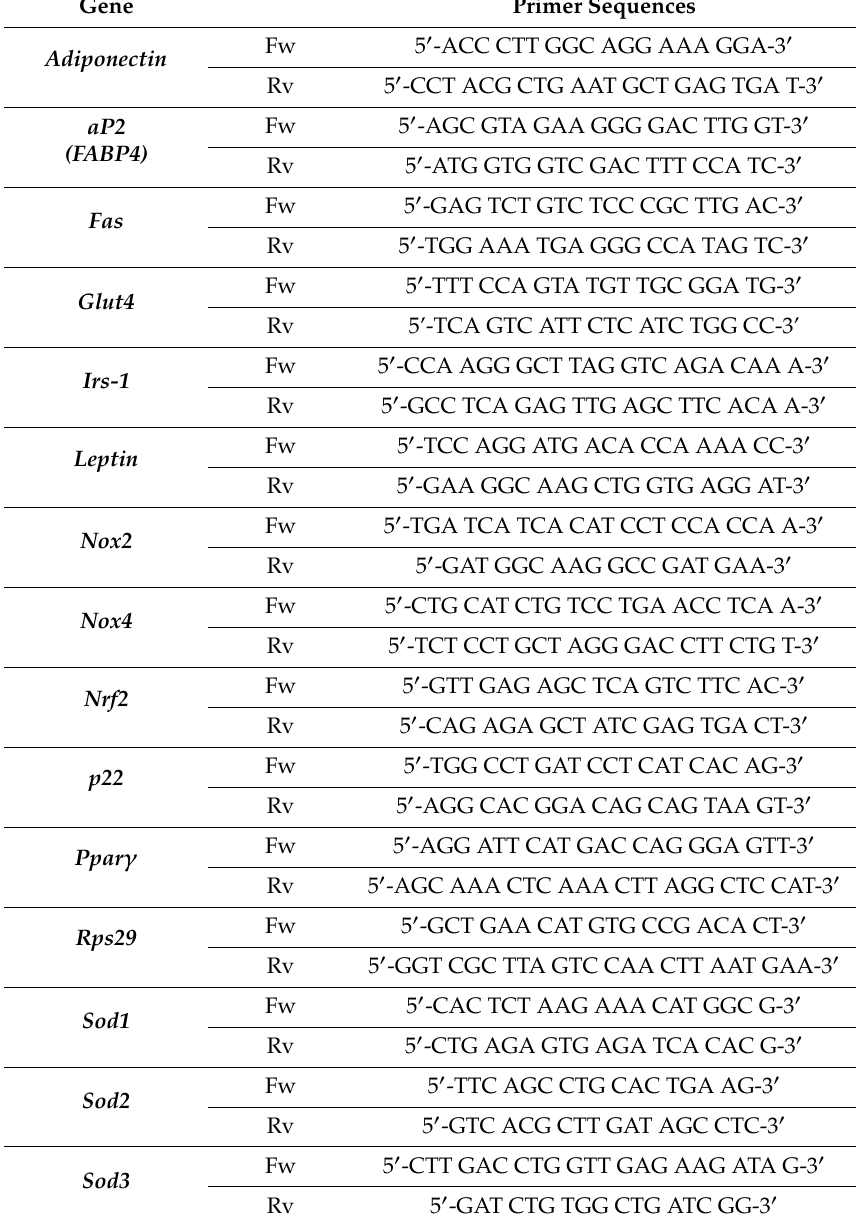
Table 1. Primers used in